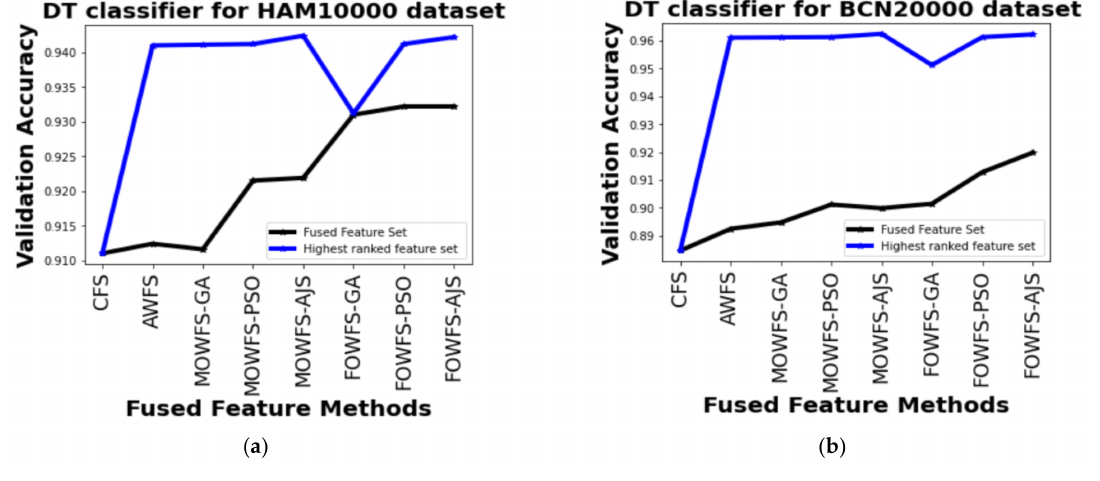
Figure 6. Comparison of validation accuracy for fused feature set and highest ranked feature set